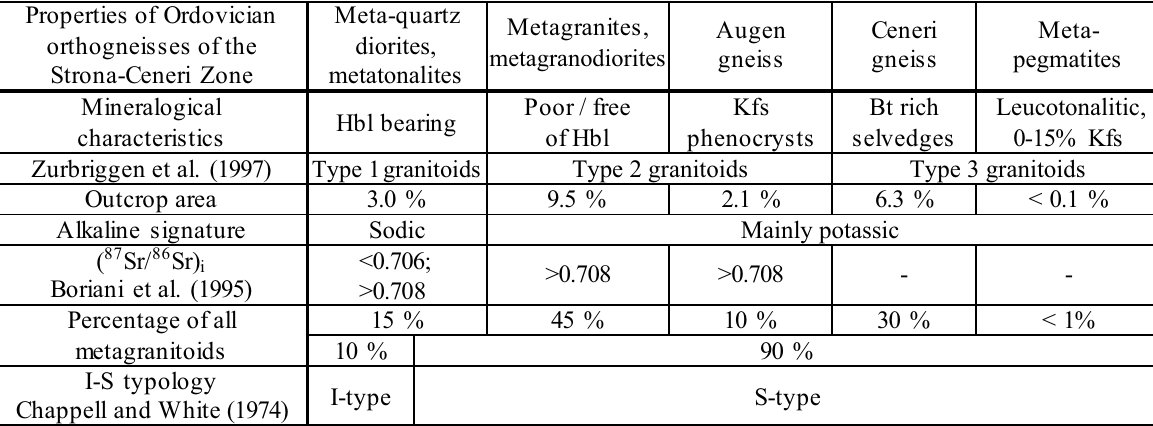
Table 1 Selected characteristics of the Ordovician metagranitoids of the Strona‑Ceneri Zone (Southern Alps) Properties of